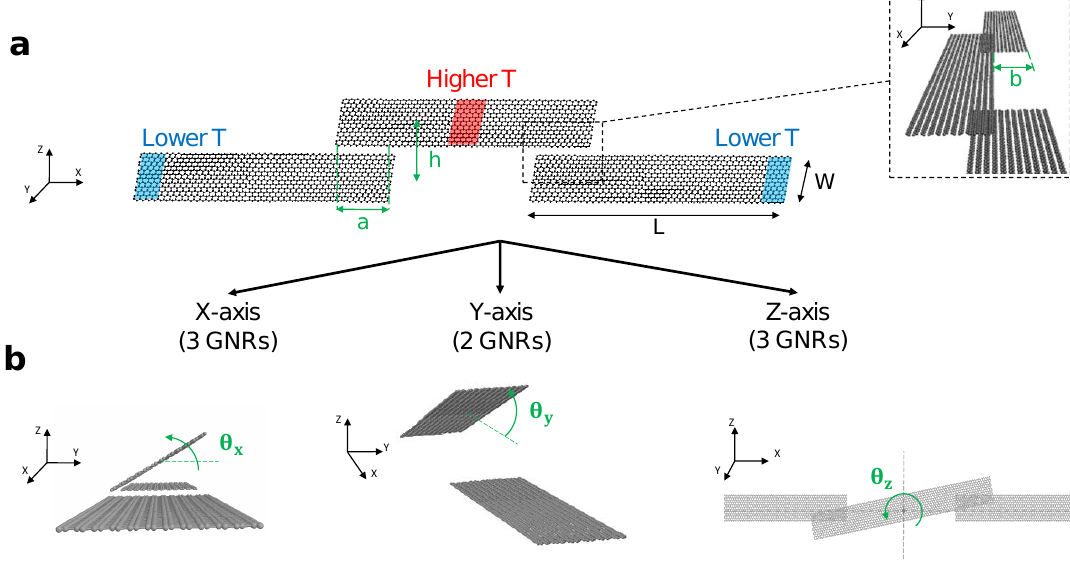
Figure 1. Networks of graphene nanoribbons (GNRs) studied by reverse non-equilibrium molecular dynamics simulations. ( a ) Configuration adopted to investigate the effect of horizontal overlap ( a , along x axis), vertical overlap ( b , along y axis) and interplanar spacing ( h , along z axis) on the R k between GNRs ( W width, L length). In the inset, the definition of b is highlighted. Muller-Plathe’s algorithm is used to assure a constant heat flux from the region of the setup with higher temperature to the lower ones. ( b ) Configurations adopted to study the effect of angular displacement ( θ x , θ y , θ z ) on the average R k between GNRs. The tested configurations have been chosen according to the one-at-a-time sensitivity approach